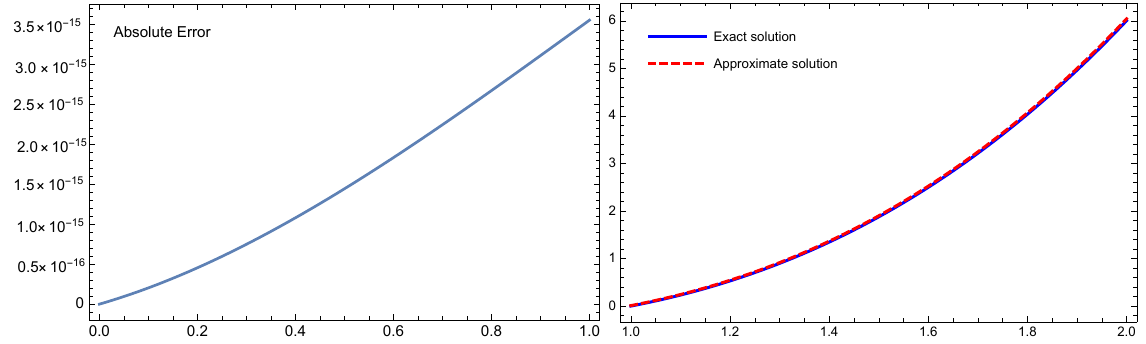
Figure 7. The absolute error ( left ), while the numerical and approximate solutions ( right ) for Example 4 with m = 3.